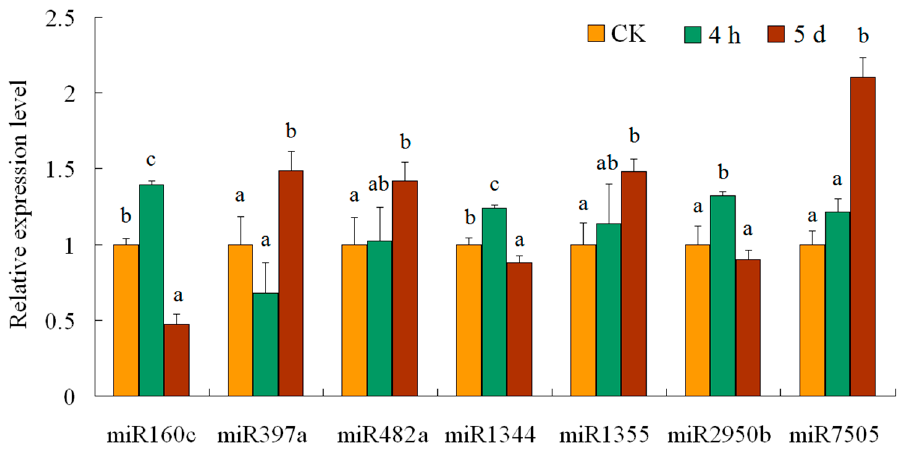
Figure 3. Real-time quantitative PCR validated expressions of seven miRNAs. The amount of expression was normalized to the level of U6. The normalized miRNA levels in control were arbitrarily set to 1. The different letters of each miRNAs present on the columns indicate significant differences at p <0.05 among the CK, 4-h and 5-d samples. Error bars represent standard error of the mean.